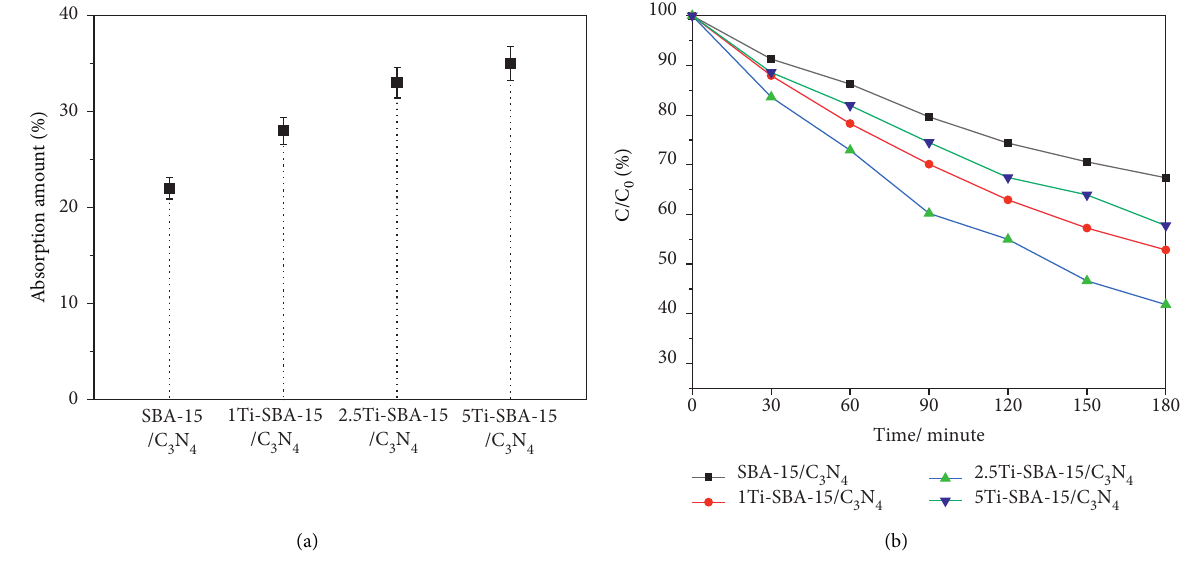
3 N 4 ; (b) 2.5Ti-SBA-15/C 3 N 4 .